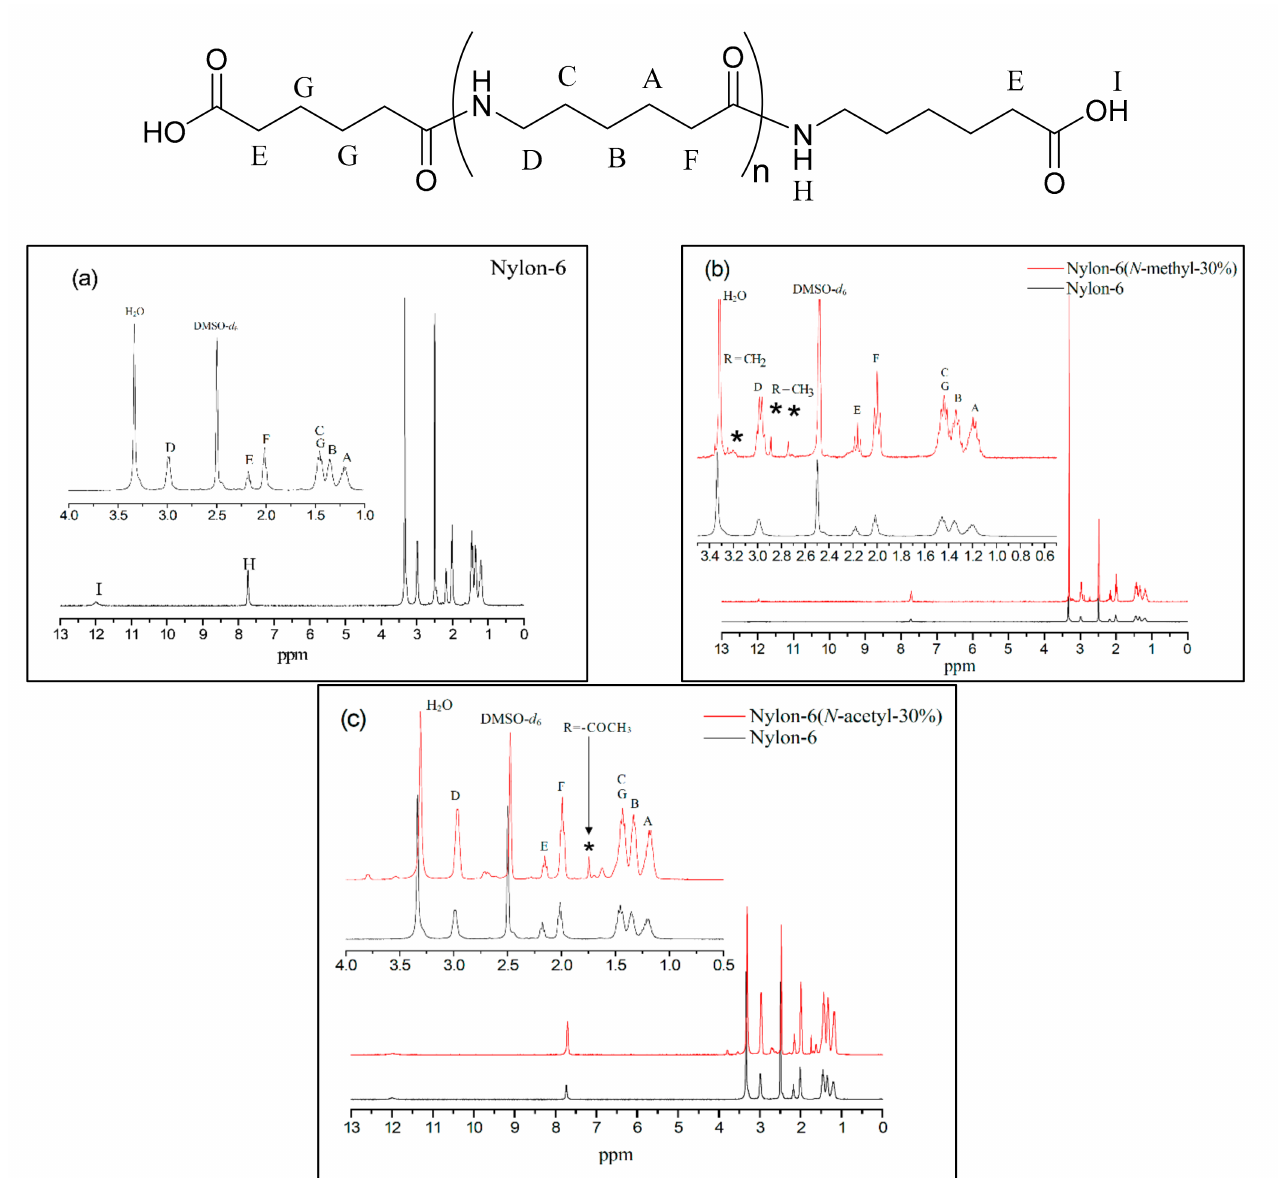
Figure 2. 1 H NMR spectra of ( a ) nylon-6, ( b ) nylon-6 and nylon-6( N -methyl-30%), and ( c ) nylon-6 and nylon-6( N -acetyl-30%). The asterisk sign represents chemical shift of N -substituted